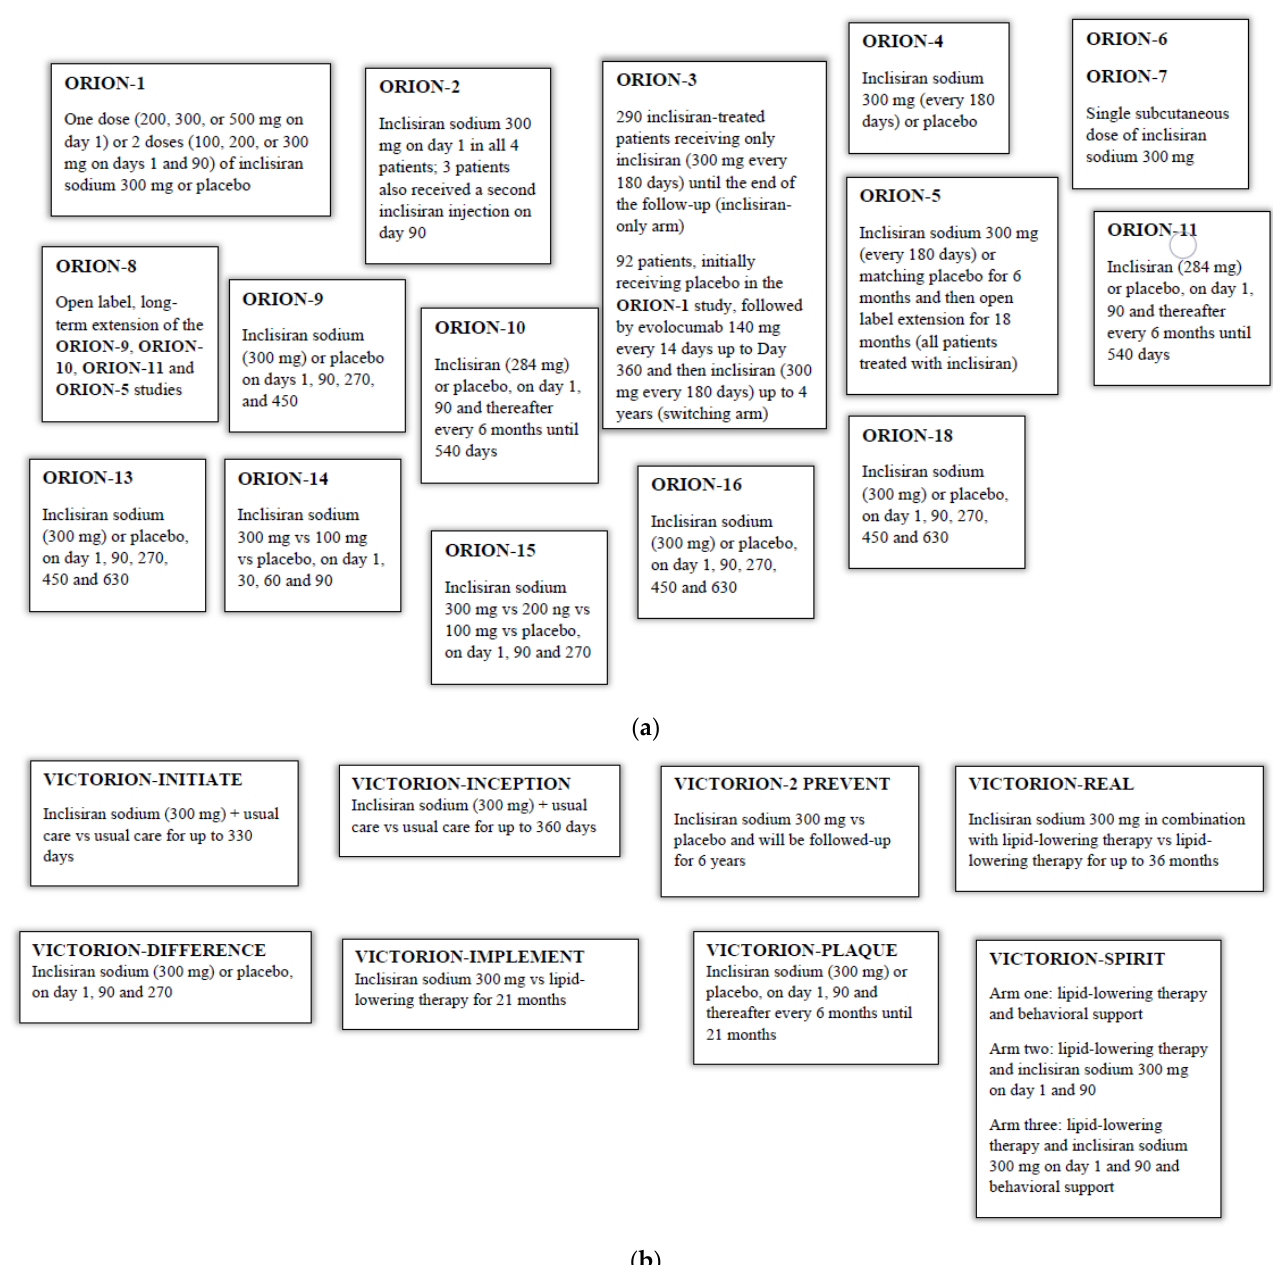
Figure 1. ( a ) Inclisiran administration in the ORION trials; ( b ) Inclisiran administration in the VICTORION trials.